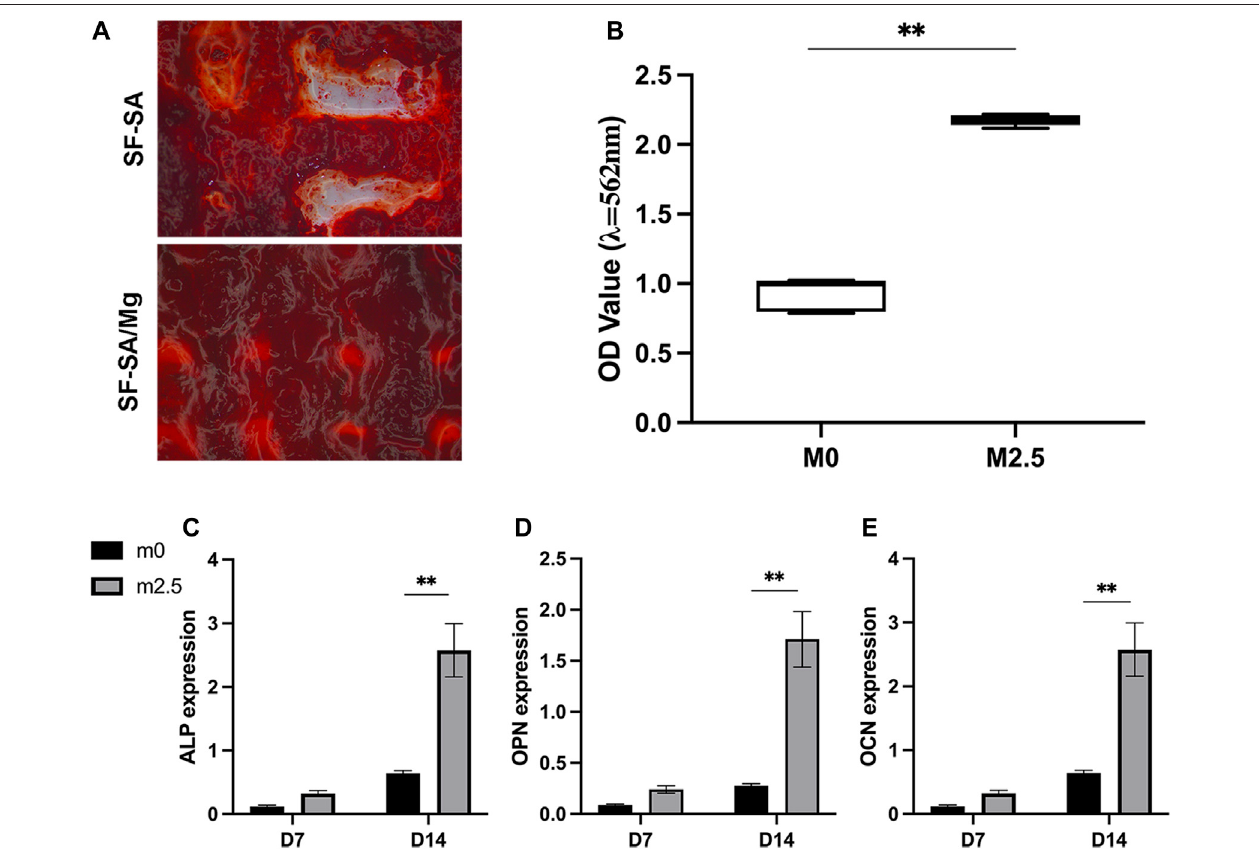
FIGURE6| 3DstructuresofSF-SAandSF-SA/MgPhydrogelscaffoldsco-culturedwithBMSCsonday14.Alizarinstaining (A) ,andquali fi cationby10%CPC (B) . ALP, OCN, and OPN expression of each sample on days 7 and 14 (C – E) .